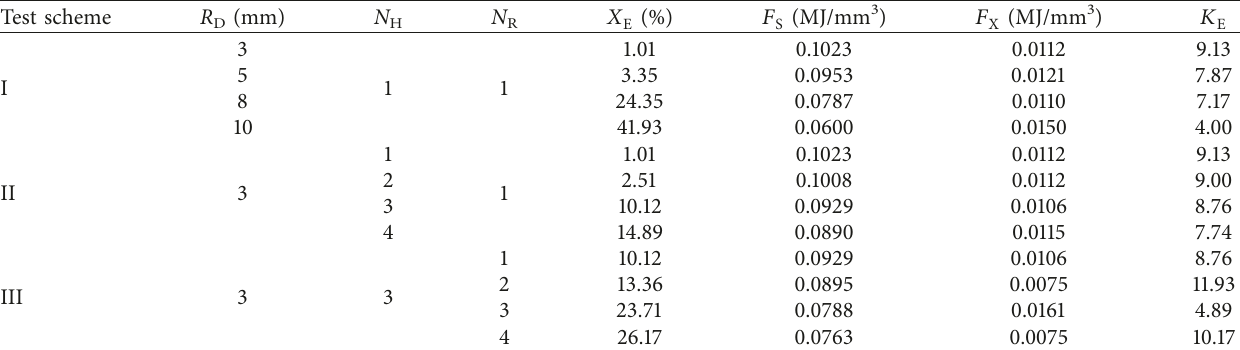
Figure 10: Sketch of the calculations of X Table 5: Energy indexes of specimens with different drilling